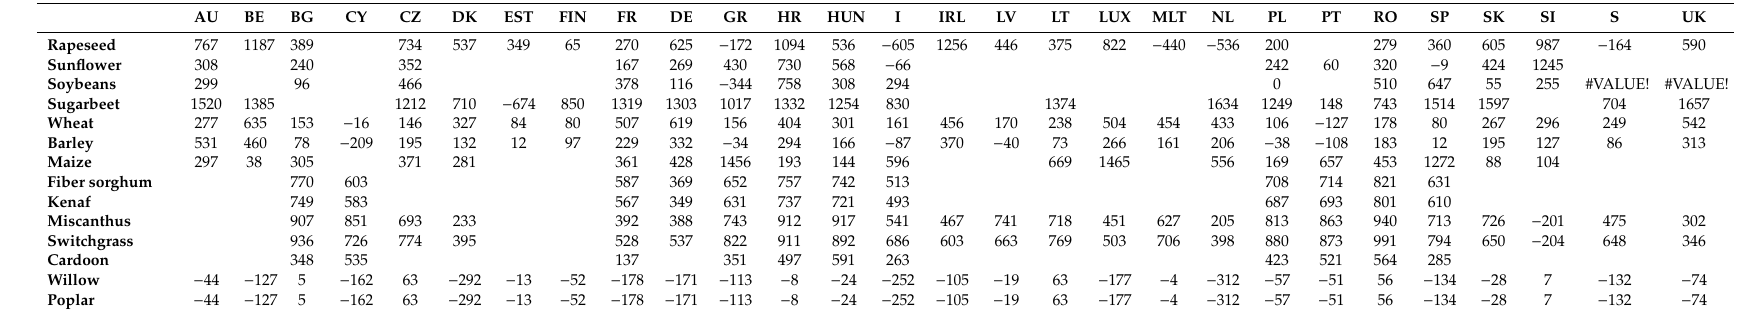
Table A10. Profitability (euro / ha / year) in low quality land.